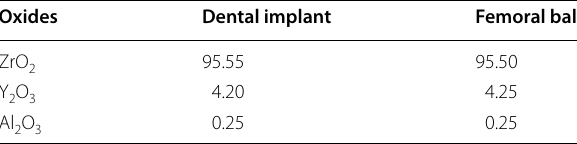
Table 2 Chemical composition of the commercial zirconia dental implants and femoral ball acquired for the studies (in % wt) Oxides Dental implant